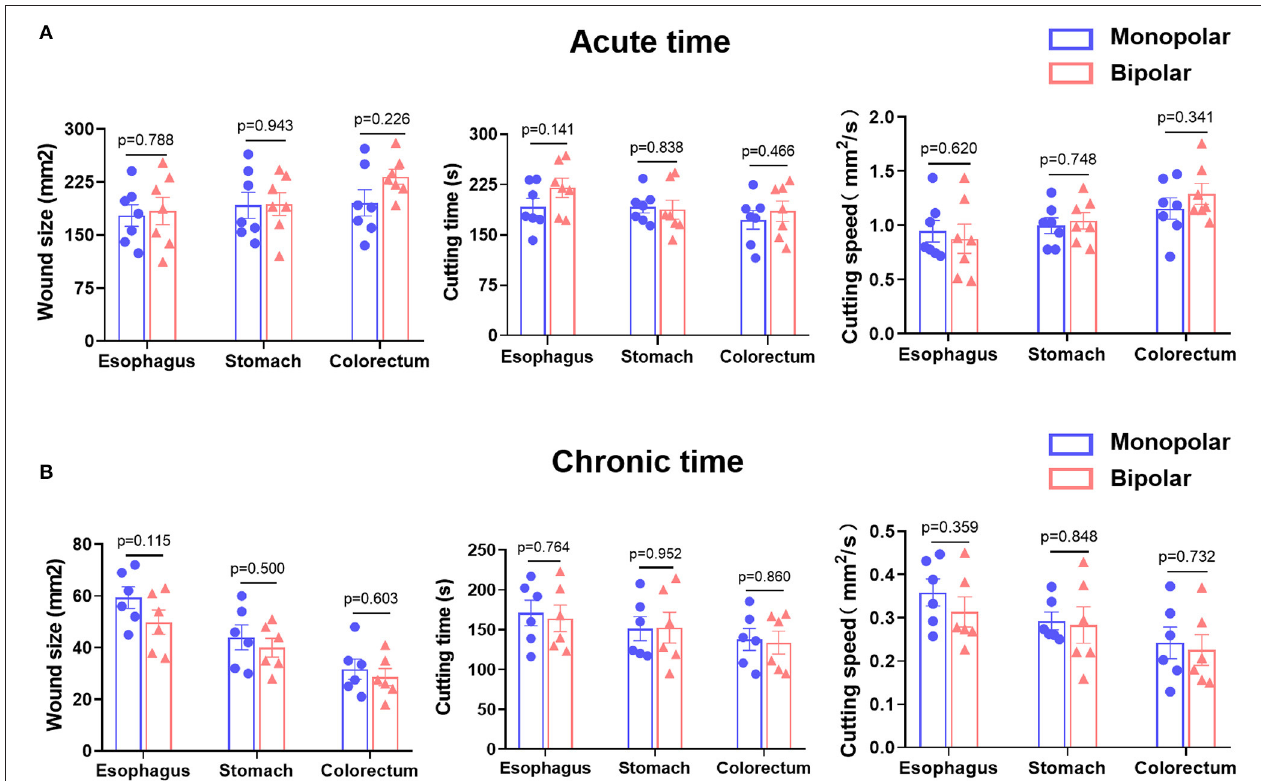
FIGURE 3 | Comparison of wound size, cutting time, and cutting speed produced by monopolar and bipolar knives in porcine esophagus, stomach, and colorectum in the acute time group (A) and chronic time group (B) . Acute time group: record results immediately after endoscopic submucosal dissection (ESD). Chronic time group: record results on the 14 th day after ESD.